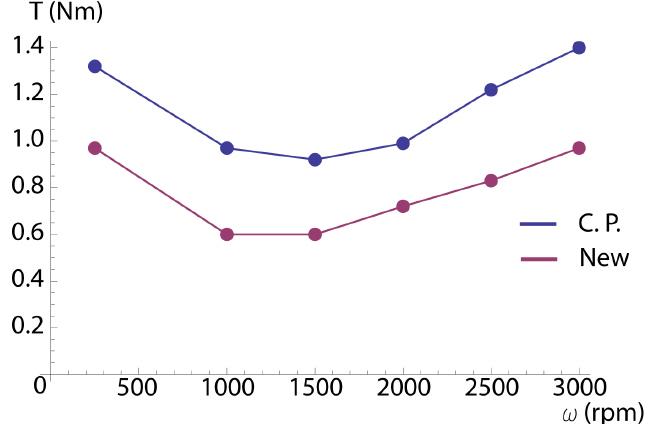
Figure 2: Vacuum pump torque